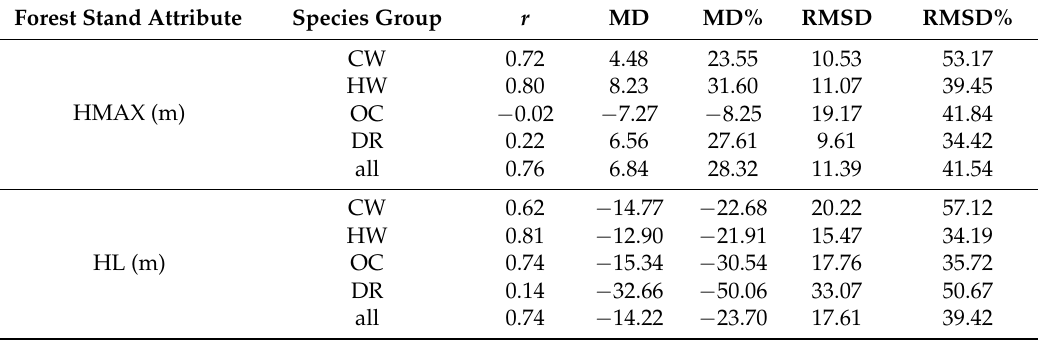
Table 4. Results of the comparison between inventory-based projections and cell-level projections based on airborne laser scanning (ALS)-derived attribute predictions. Forest Stand